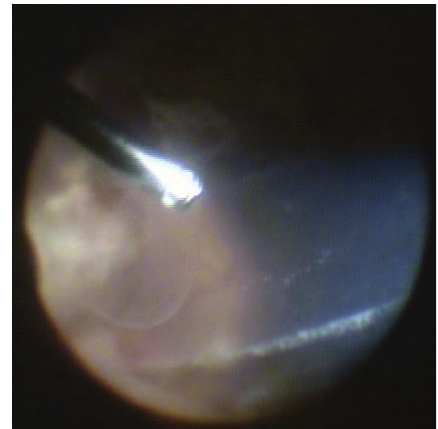
Figure 2: Picture taken during surgery showing severe vitritis.